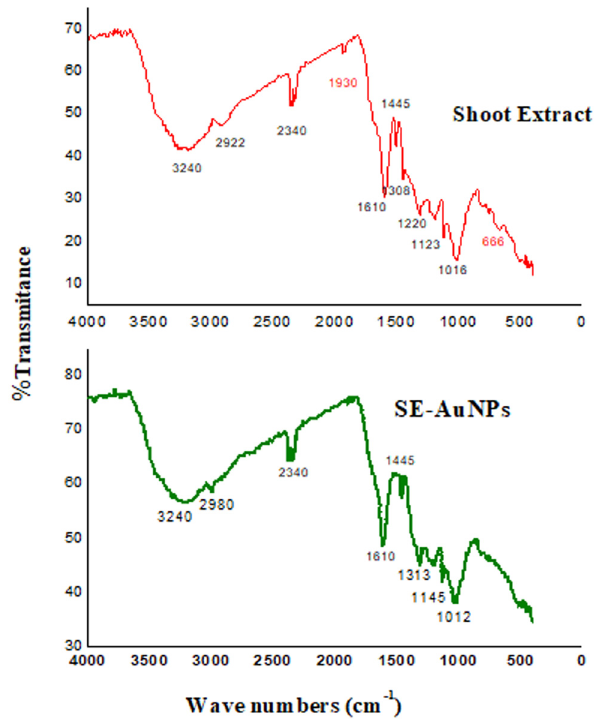
Figure 7: Comparative IR spectra of SE and SE - mediated AuNPs showing transmittance levels at di ff erent wavenumbers repre - senting stretches of various functional groups.